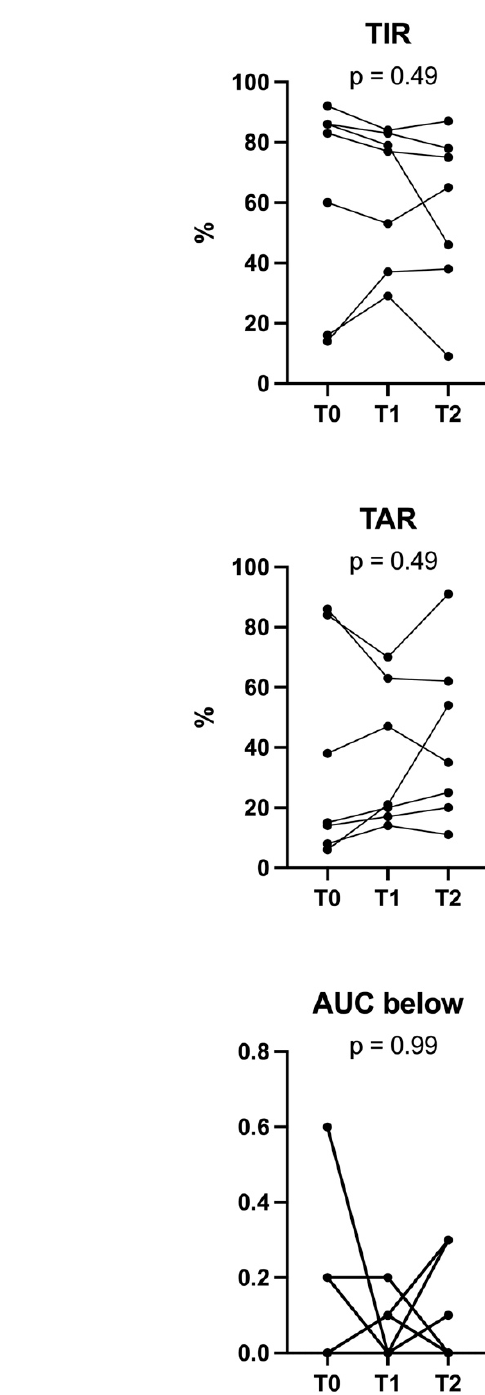
Figure 2. Illustration of Time in range (TIR), time above range (TAR), time below range (TBR), estimated HbA1c, AUC above, and AUC below limit at baseline time and after 4 and 12 weeks of testosterone replacement treatment.